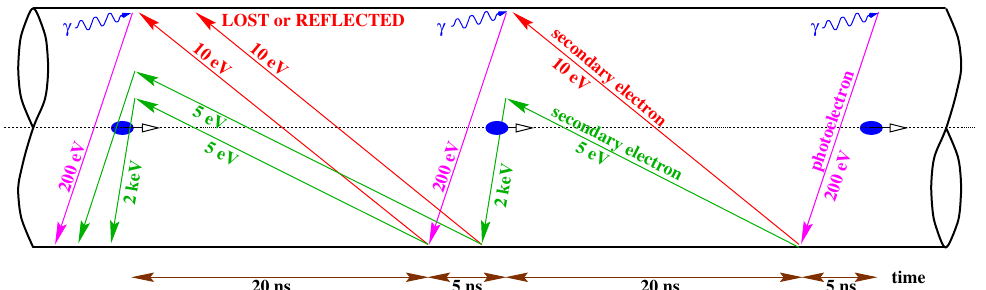
FIG. 1. Schematic of electron-cloud buildup in the LHC.